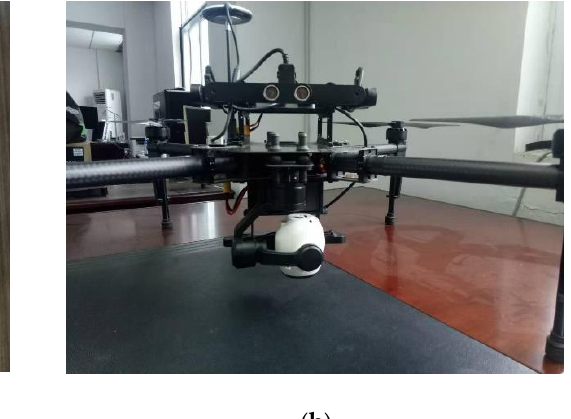
Table 2. Measurement noise setting.